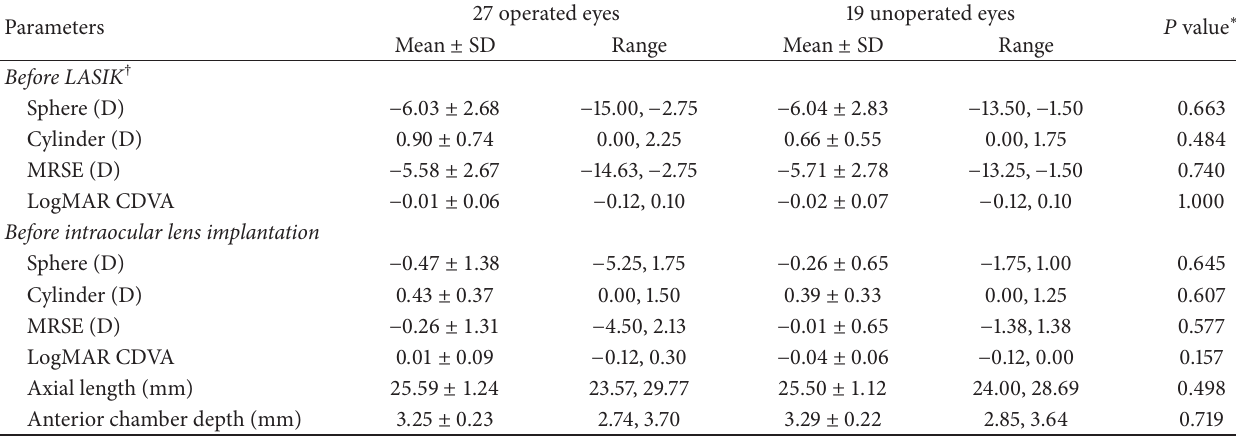
Table 2: Intraocular lens formula accuracy (25 eyes with pre-laser in situ keratomileusis data available). Formula